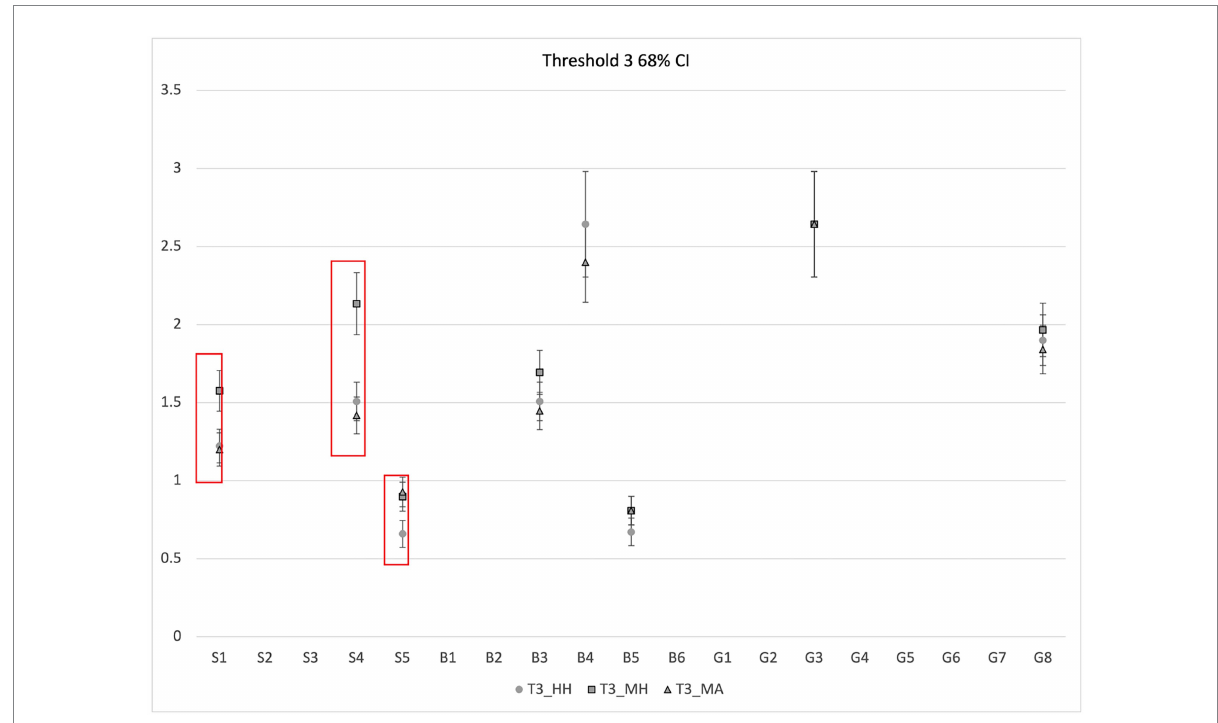
FIGURE 5 CFA threshold 3 with 68% CI for the HH, MA, and MH scoring approaches.